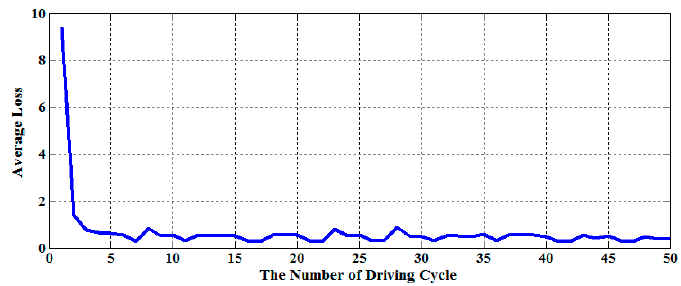
Figure 8. Track of loss in the online application.